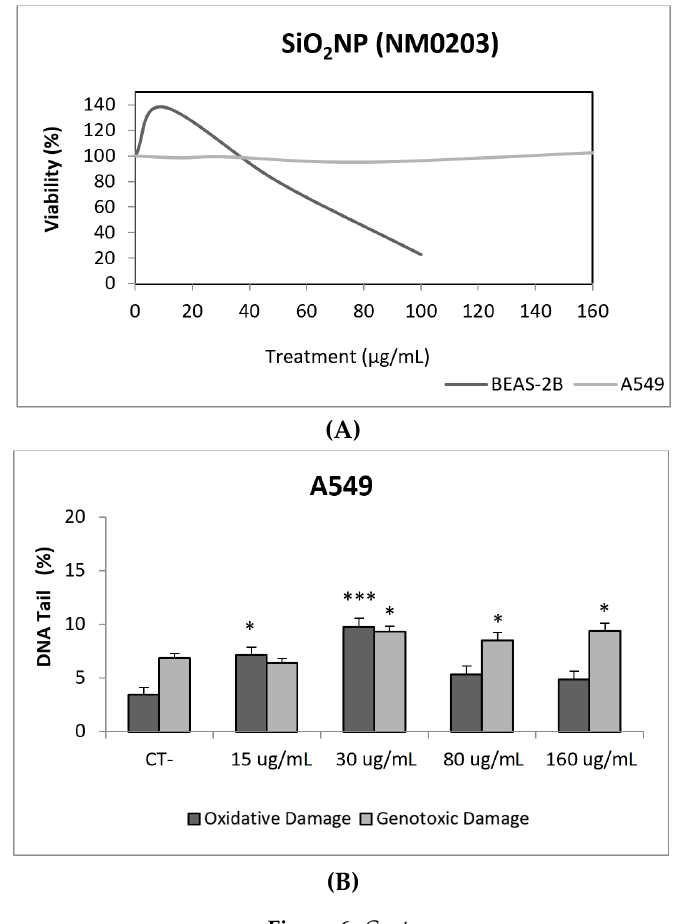
Figure 5. Results from the SiO 2 NPs (NM200), on A549 and BEAS-2B cells. ( A ) Toxicity curves for both cell lines. ( B ) Genotoxicity results obtained in A549 cells. ( C ) Genotoxicity results obtained in BEAS-2B cells. Genotoxicity data are plotted as mean ± SEM of two independent experiments. * p ≤ 0.05, *** p ≤ 0.001 (one way-ANOVA). CT, control.